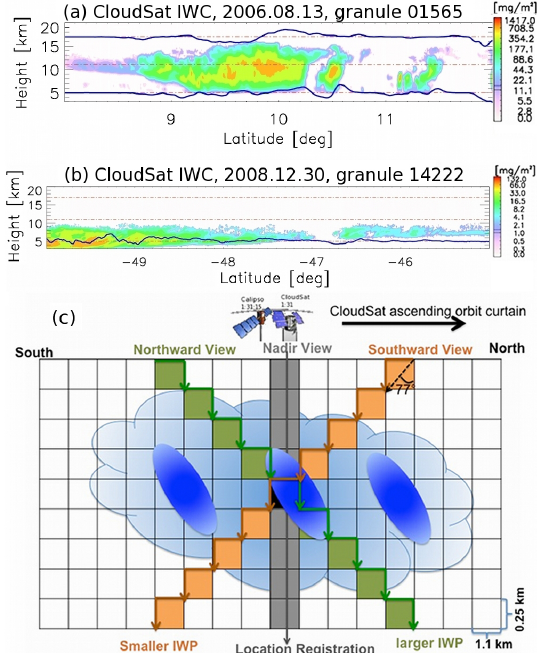
Figure 1. (a) and (b) show examples of ice water content (IWC) curtains from CloudSat 2B-CWC-RO product (V008). The curtains are divided into two sectors as indicated by the black dash-dotted lines. The color scale is linear with the largest (smallest) values in orange (white). The blue curves whose zero values are centered around the 5 and 17km vertical levels illustrate the ice water path differences ( (cid:49) IWP) derived from the algorithm demonstrated in the diagram (c) for layer 5–11 and 11–17km. See text for details of (c) and the sign convention of the blue curves. The ratio is approxi- mately 4:1 between horizontal and vertical scales for all panels; therefore, 77 ◦ looks like 45 ◦ in (c) because of the squeeze of the horizontal scale. Integration paths of the slantwise view are illus- trated by green and orange arrows in (c) .